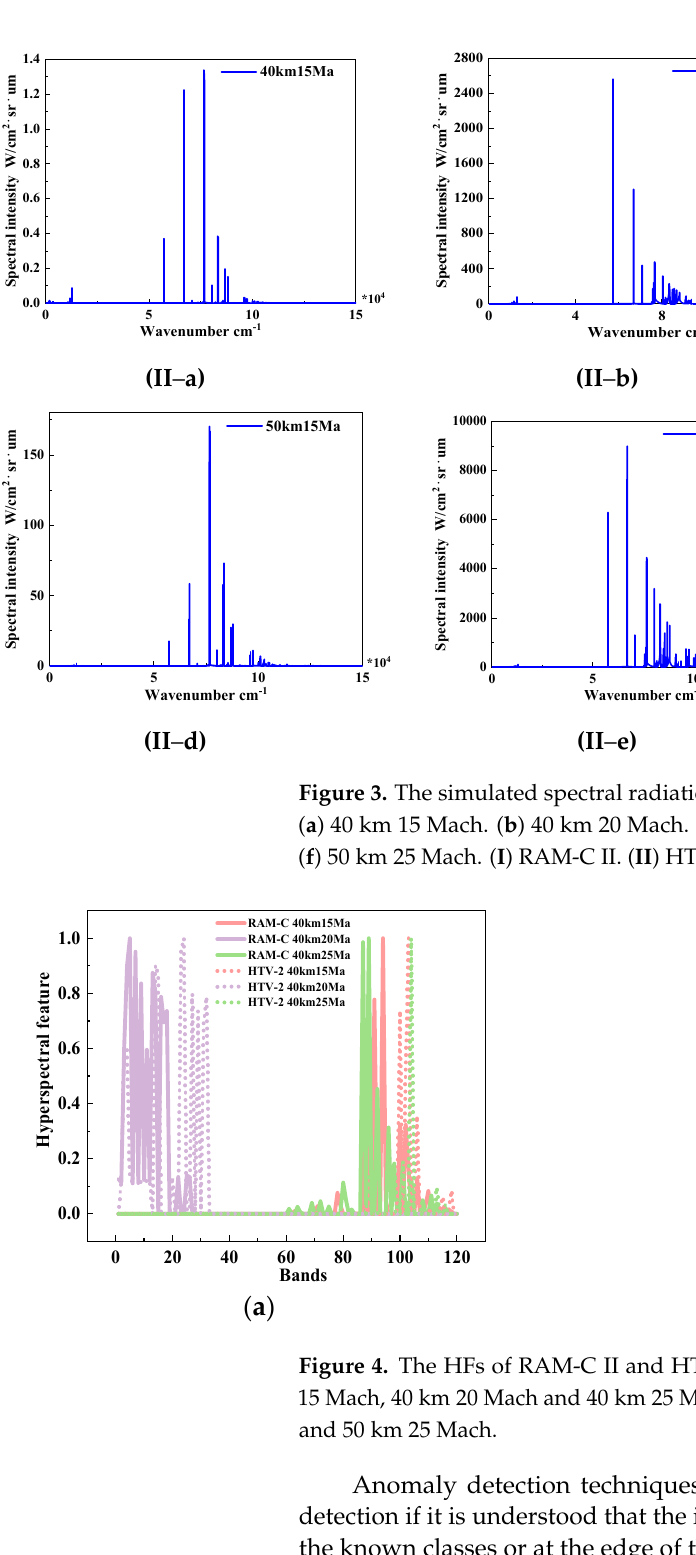
Figure 5. Extracted PCA features.